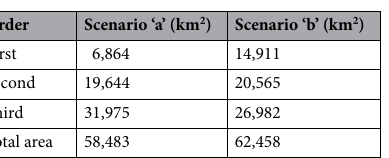
Table 2. Recommended order for assigning protection to priority areas outside of Sulawesi’s current protected area network.